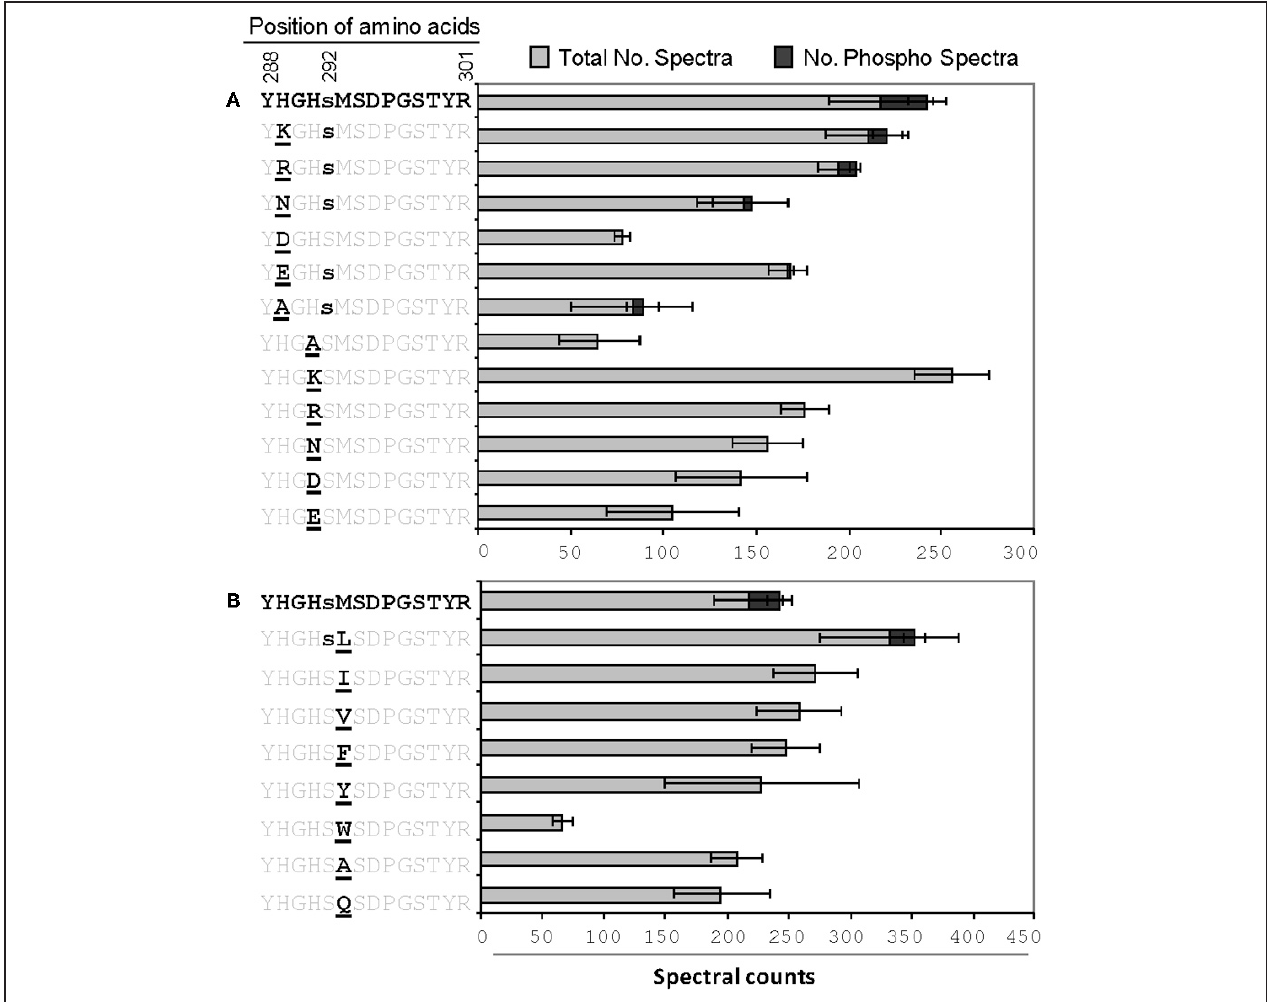
FIGURE A2 | The effects of single changes to (A) His 289 /His 291 , or (B) Met 293 . The spectral count data presented are means of three technical replicates each for both phosphorylated and non-phosphorylated peptides.